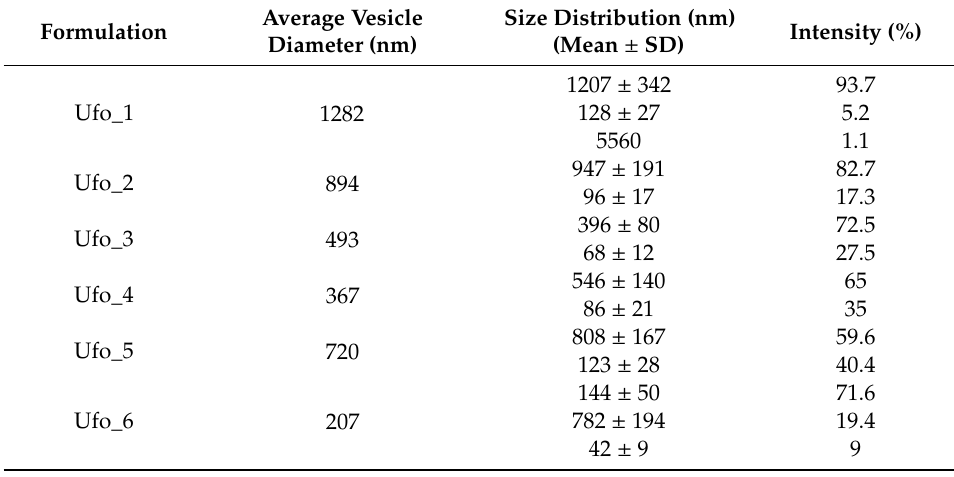
Table 2. Summary of size distribution analysis of ufosomes.